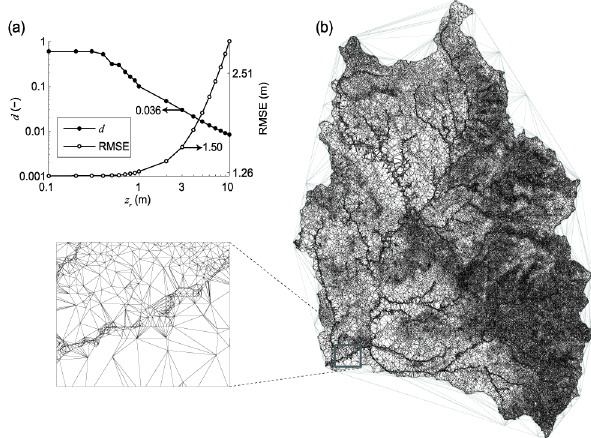
Fig. 8. (a) Relations between vertical accuracy z r (maximum eleva- tion difference between TIN and DEM) and horizontal point density d and RMSE between DEM and TIN elevations. (b) Voronoi poly- gons of selected TIN with z r = 3m corresponding to d = 0 . 036 and RMSE = 1.5m.